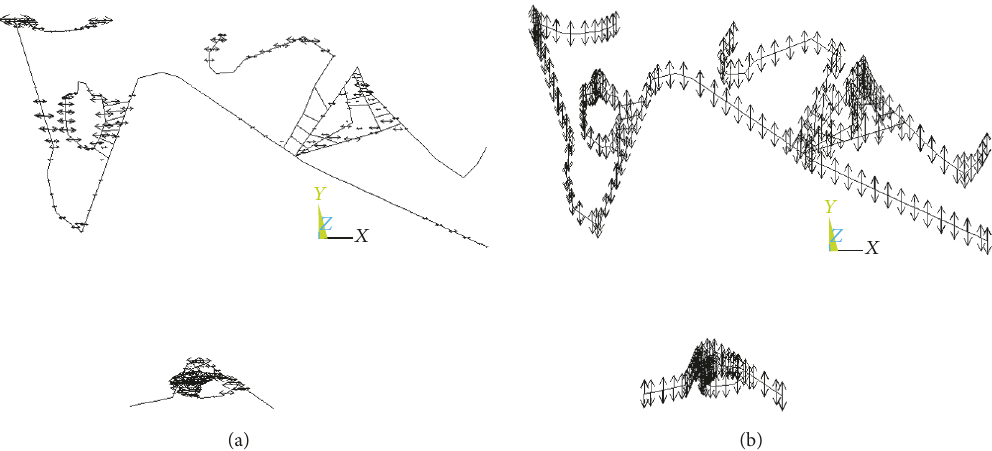
Figure 8: The distribution nephograms of the first principal stress in the mineral boundary of the kernstone under uniaxial simulations: (a) uniaxial compression and (b) uniaxial